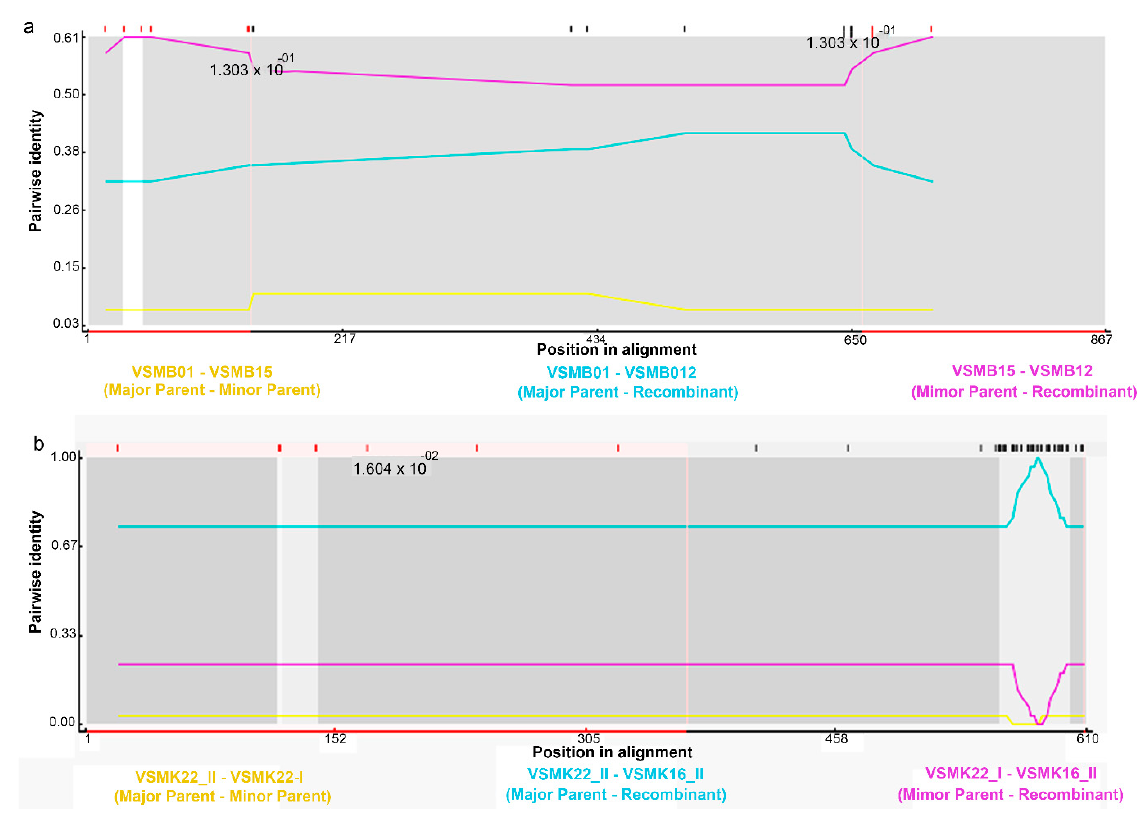
Figure 4. Assessment of recombination in duplicate CRs of all individuals: ( a ) CR2; ( b ) CRs detected using RDP software.